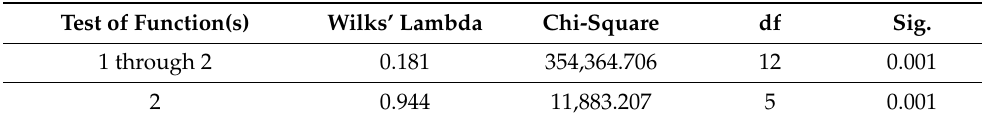
Table 7. Canonical Discriminant analysis efficiency